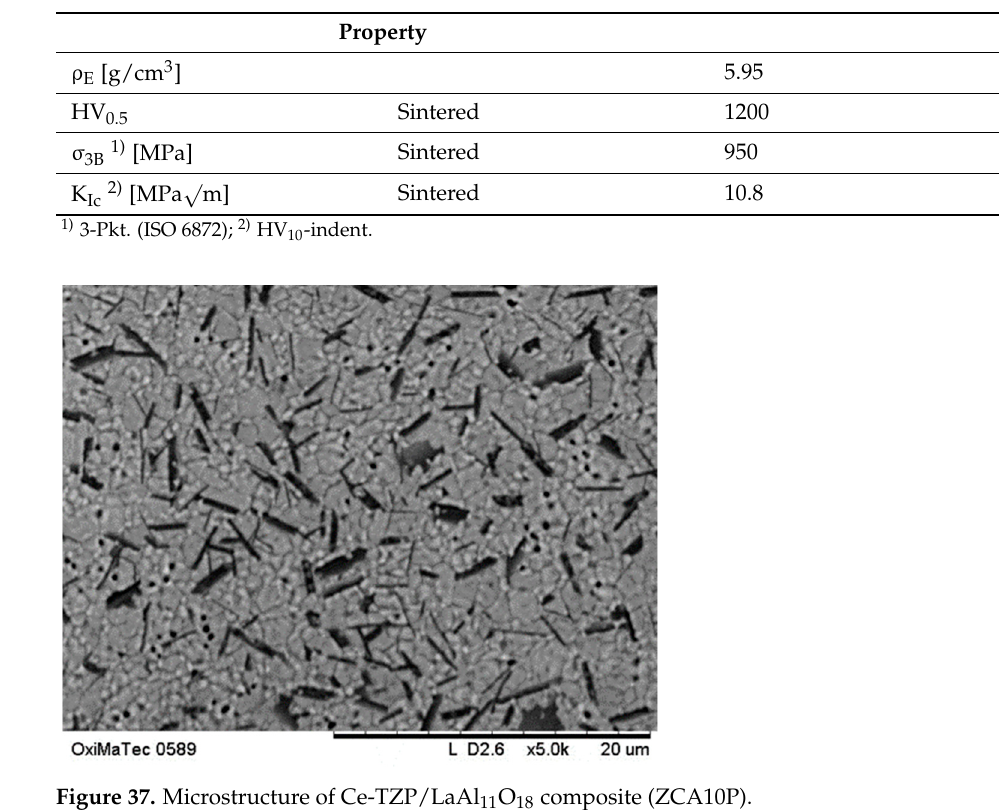
Figure 37. Microstructure of Ce-TZP/LaAl 11 O 18 composite (ZCA10P). Table 8. Mechanical properties of Y-Ce-TZP/Al 2 O 3 /LaAl 11 O 18 .